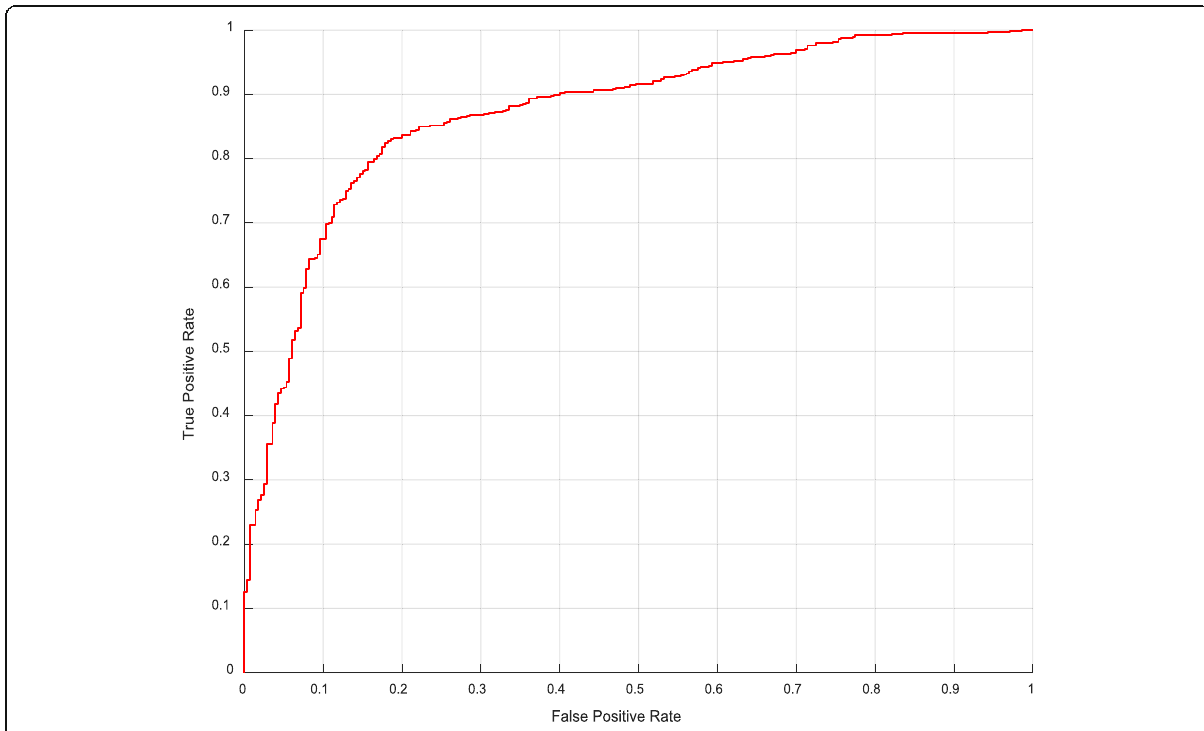
Fig. 12 ROC curves of the detection results on the Avenue dataset